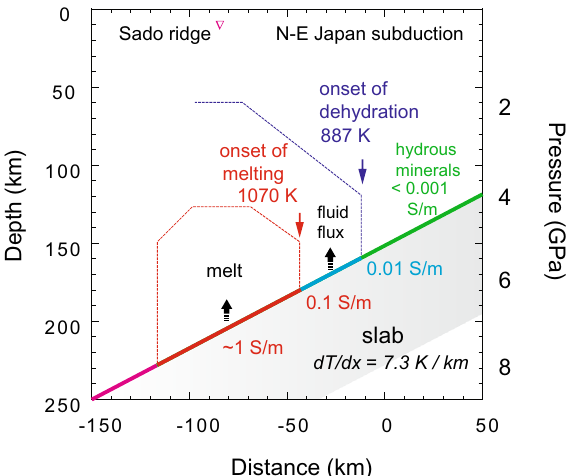
Figure 8. Application of the glaucophane geothermometer to N–E Japan subduction zone. Two temperature- fixed points for the N–E Japan subduction slab are determined using the electrical conductivity model discussed in Fig. 6. The electrical conductivity structure of the subduction system is taken from Toh et al. 2006 50 . The green, blue, and red zones were determined based on the electrical conductivity of the wedge mantle adjacent to the slab surface. The areas marked by dashedlines indicate high conductivity regions in the mantle